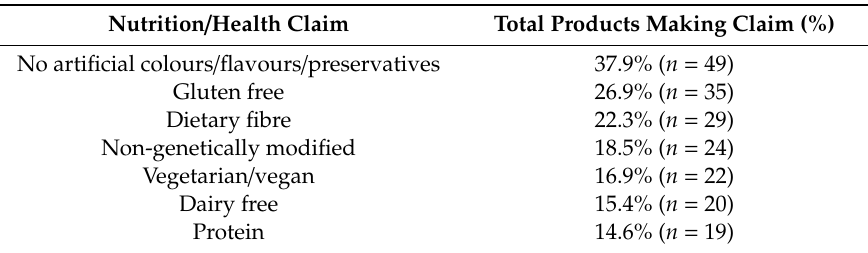
Table 5. Rank order of on-pack